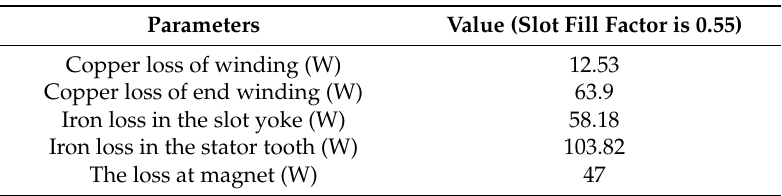
Table 2. The loss of the initial EHA driving motor.